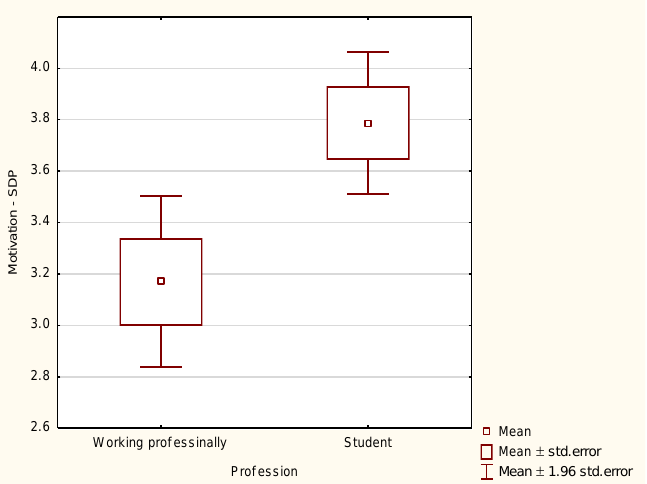
Figure 11. Differences between students and professionally active people in terms of their consideration of sustainable development when choosing a means of transport. The interaction between the level of managing SDP and the occupation of the group of respondents choosing a car in different directions is shown in Figure 12.